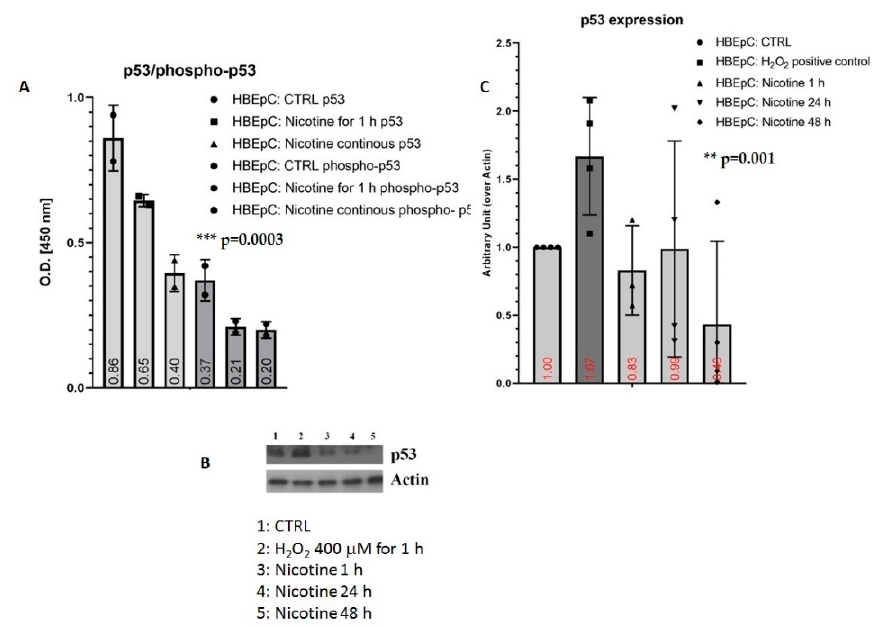
Figure 7. Induction of p53 and phospho-p53 induced by nicotine in HBEpC. ( A ): ELISA assay. ( B ): Western blotting experiments, ( C ): densometric analysis. Experiments are performed at least two times in triplicate. Statistical significance is analyzed with one-way ANOVA with multiple-com- parison and post hoc test with Bonferroni correction. In the Supplementary Materials, raw data of Western blotting are reported.